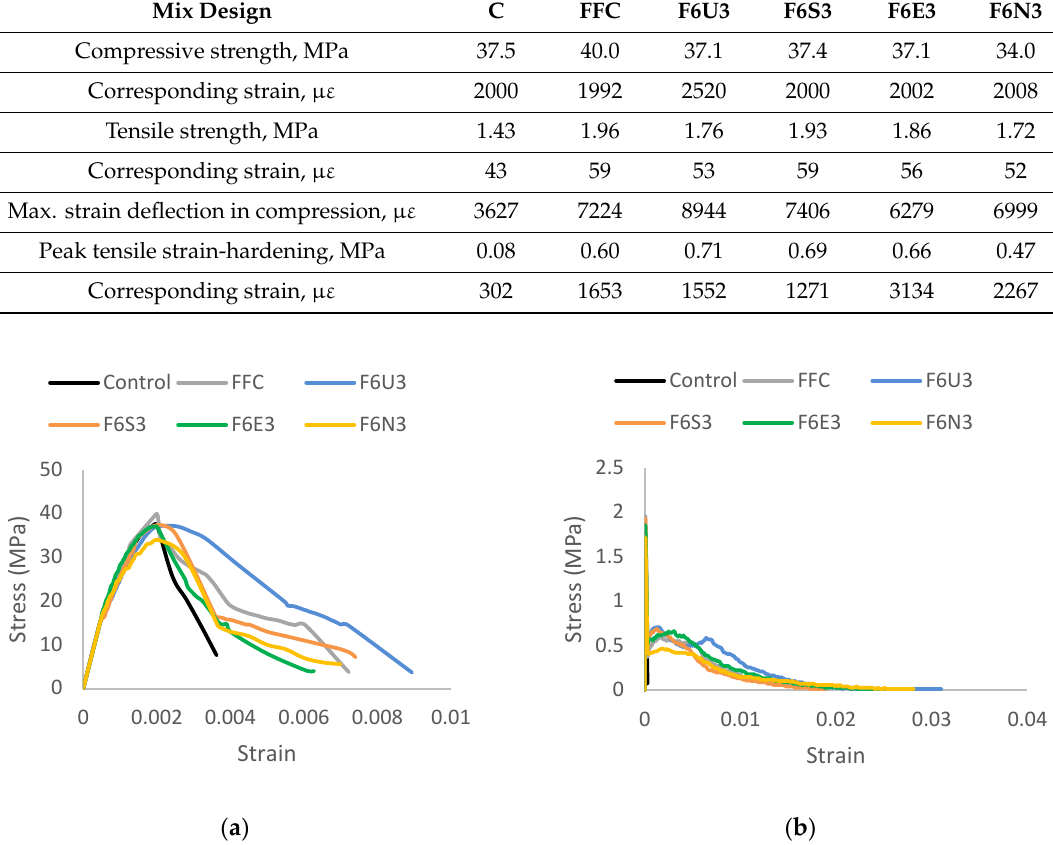
Figure 13. HyFRC tensile stress – strain curve comparison: ( a ) uniaxial compression, ( b ) uniaxial tension.